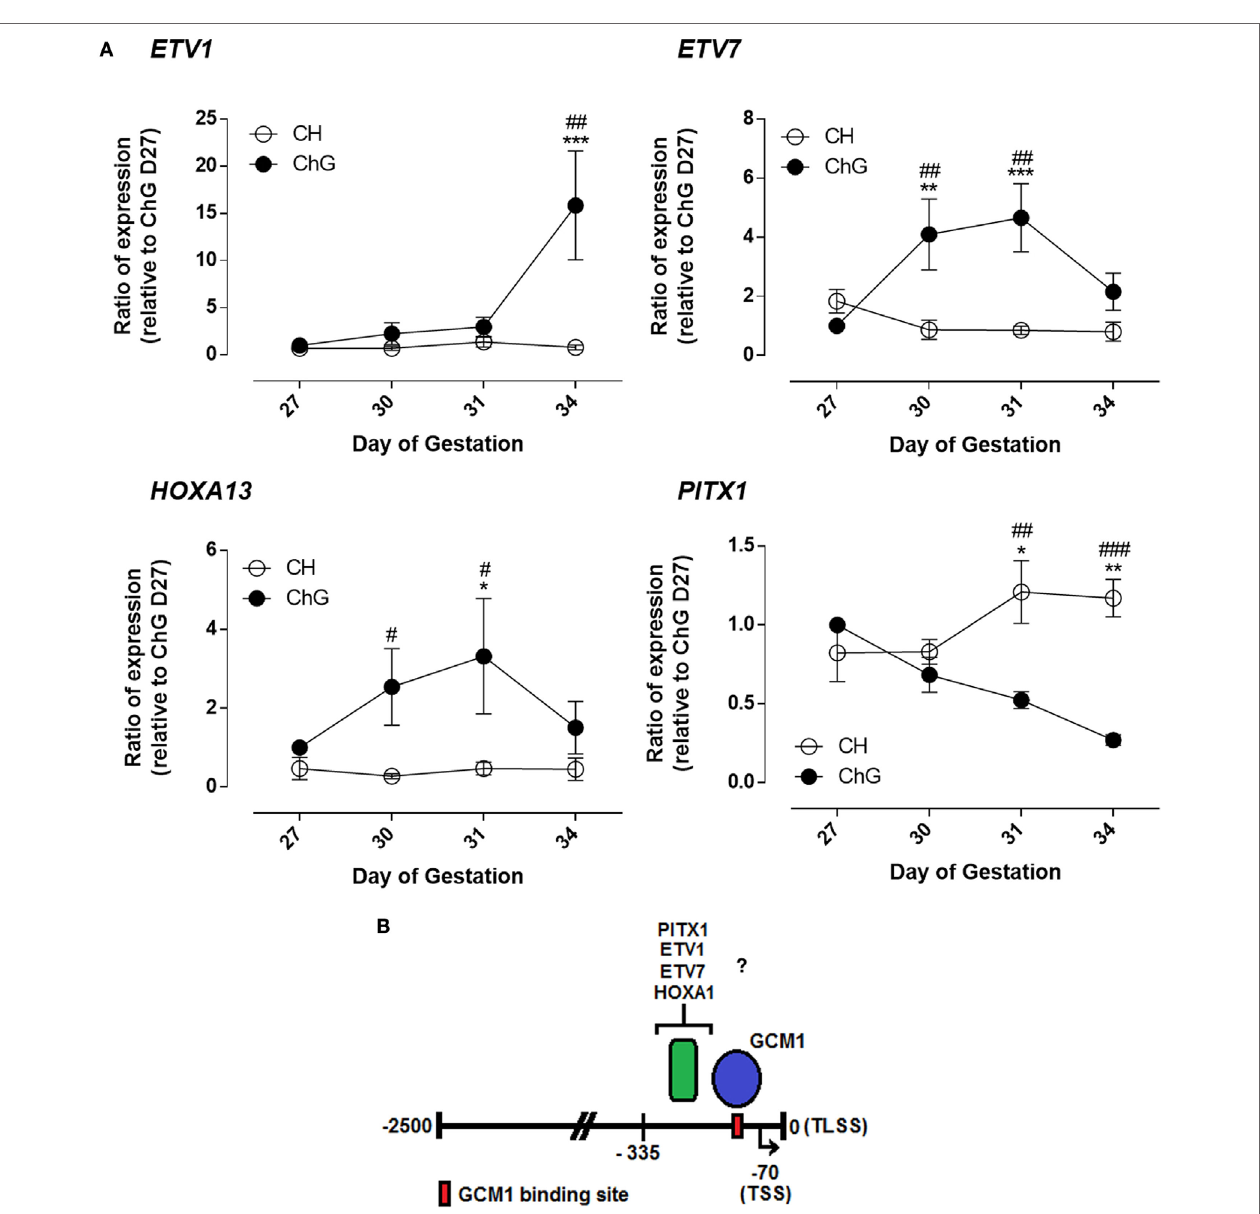
FigUre 4 | Glial cells missing 1 (GCM1) binding partners are differentially expression in vivo during differentiation of chorionic girdle (ChG) trophoblast cells. (a) mRNA expression of ETV1 , ETV7 , HOXA13 , and PITX1 in ChG and chorion tissues between days 27 and 34 of pregnancy, as determined by microarray analysis ( n = 4). * p < 0.05, ** p < 0.01, *** p < 0.001 relative to day 27 ChG, # p < 0.05, ## p < 0.01, ### p < 0.001, relative to time matched chorion. (B) Schematic of the LHB promoter showing directly bound GCM1-binding site and region of potential binding by other transcription factors. TLSS is translational start site, TSS shown by black arrow is transcriptional start site. Numbers are relative to